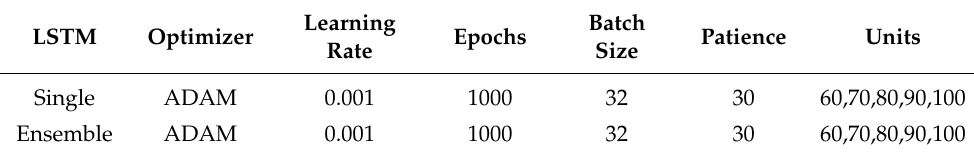
Table 5. Hyperparameter settings of the LSTM models.